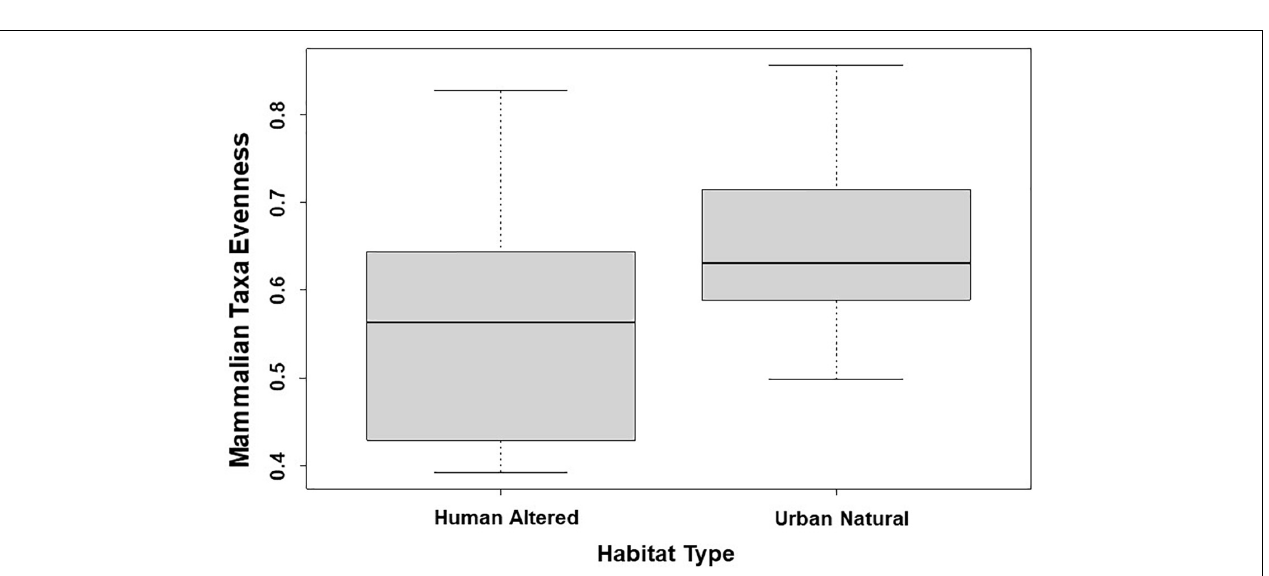
FIGURE 4 | Patterns among mammalian taxa evenness and type of habitat across 31 study sites. Points and whiskers on the plot represent the mean and standard error.